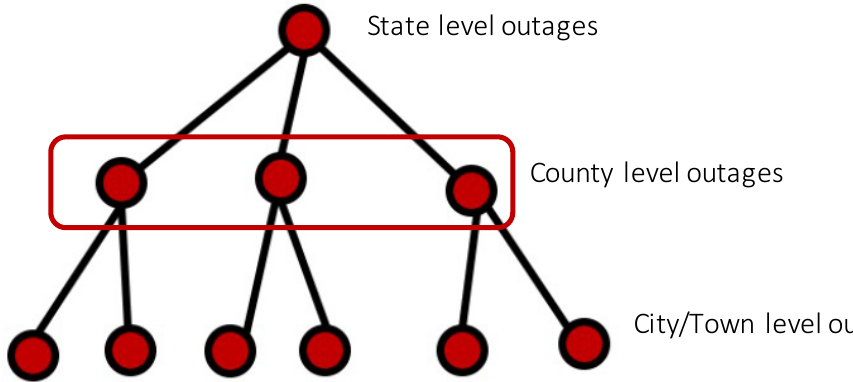
Figure 4. Hierarchical representation of